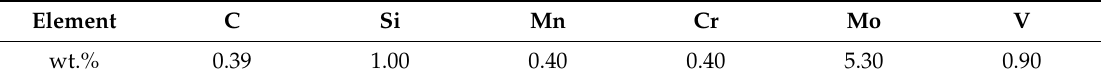
Table 1. Chemical composition of the investigated AISI H13